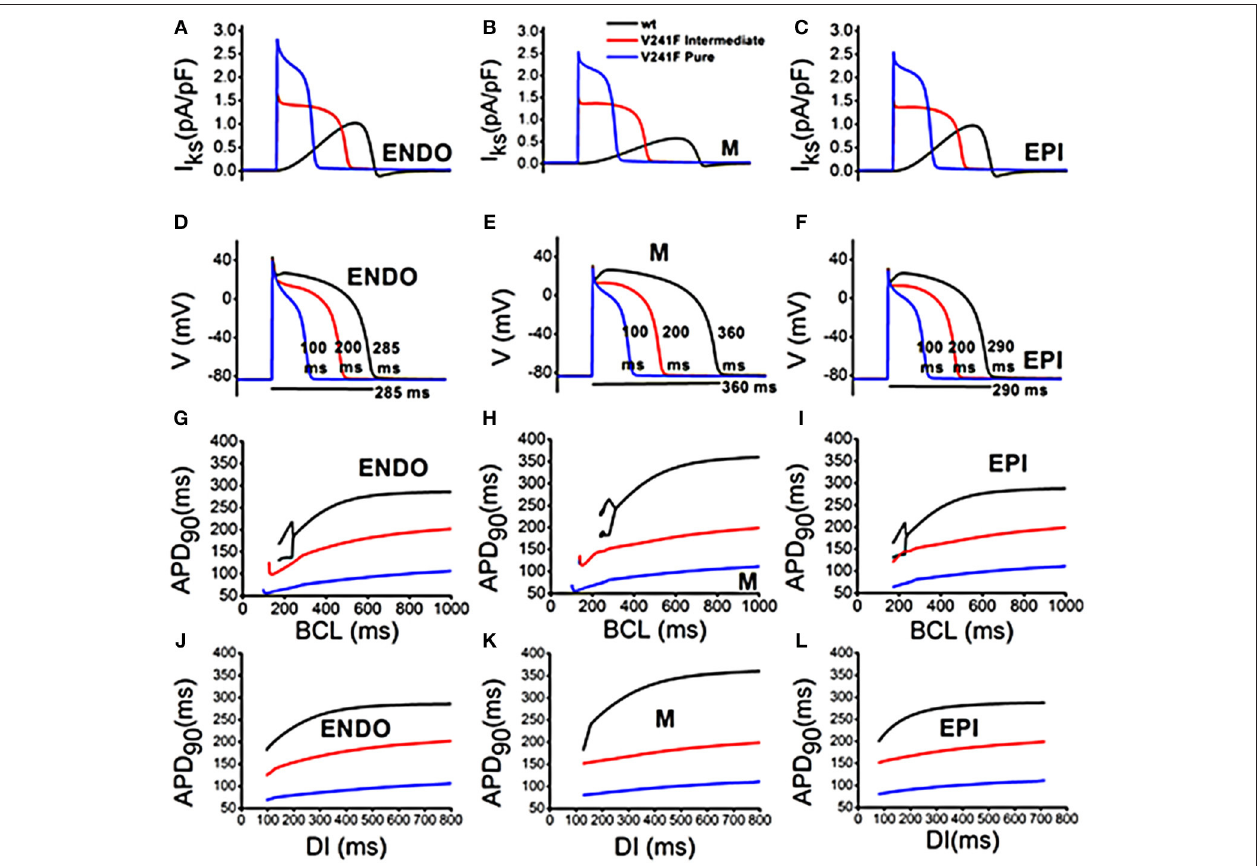
FIGURE 1 | Cardiac single cell response of WT and variants of intermediate and pure V241F mutation condition in 3 type of cell: (A) Slow delayed rectifier K + current ( I Ks ) in endocardial cell (B) Slow delayed rectifier K + current ( I Ks ) in mid-myocardial cell (C) Slow delayed rectifier K + current ( I Ks ) in epicardial cell (D) APD profile in endocardial cell (E) APD profile in mid-myocardial cell (F) APD profile in epicardial cell (G) APD according to BCL in endocardial cell (H) APD according to BCL in mid-myocardial cell (I) APD according to BCL in epicardial cell (J) APD according to DI in endocardial cell (K) APD according to DI in mid myocardial cell (L) APD according to DI in epicardial